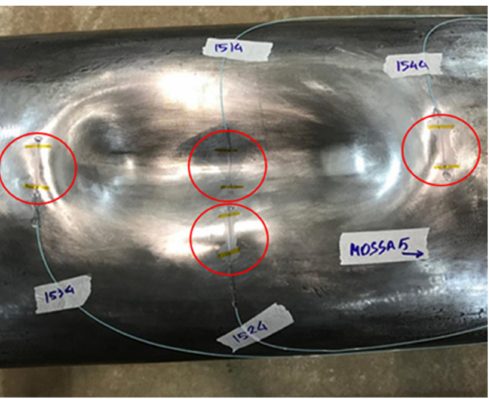
Figure 3. Location of four Bragg sensors belonging to two optical fibers mounted in the dent region of a tested